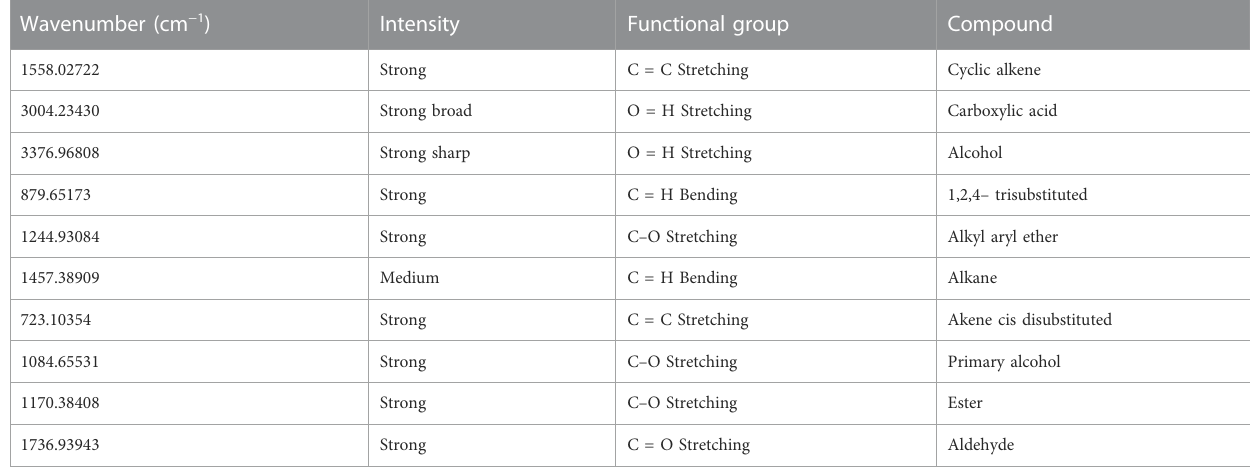
TABLE 5 FTIR spectrum analysis.